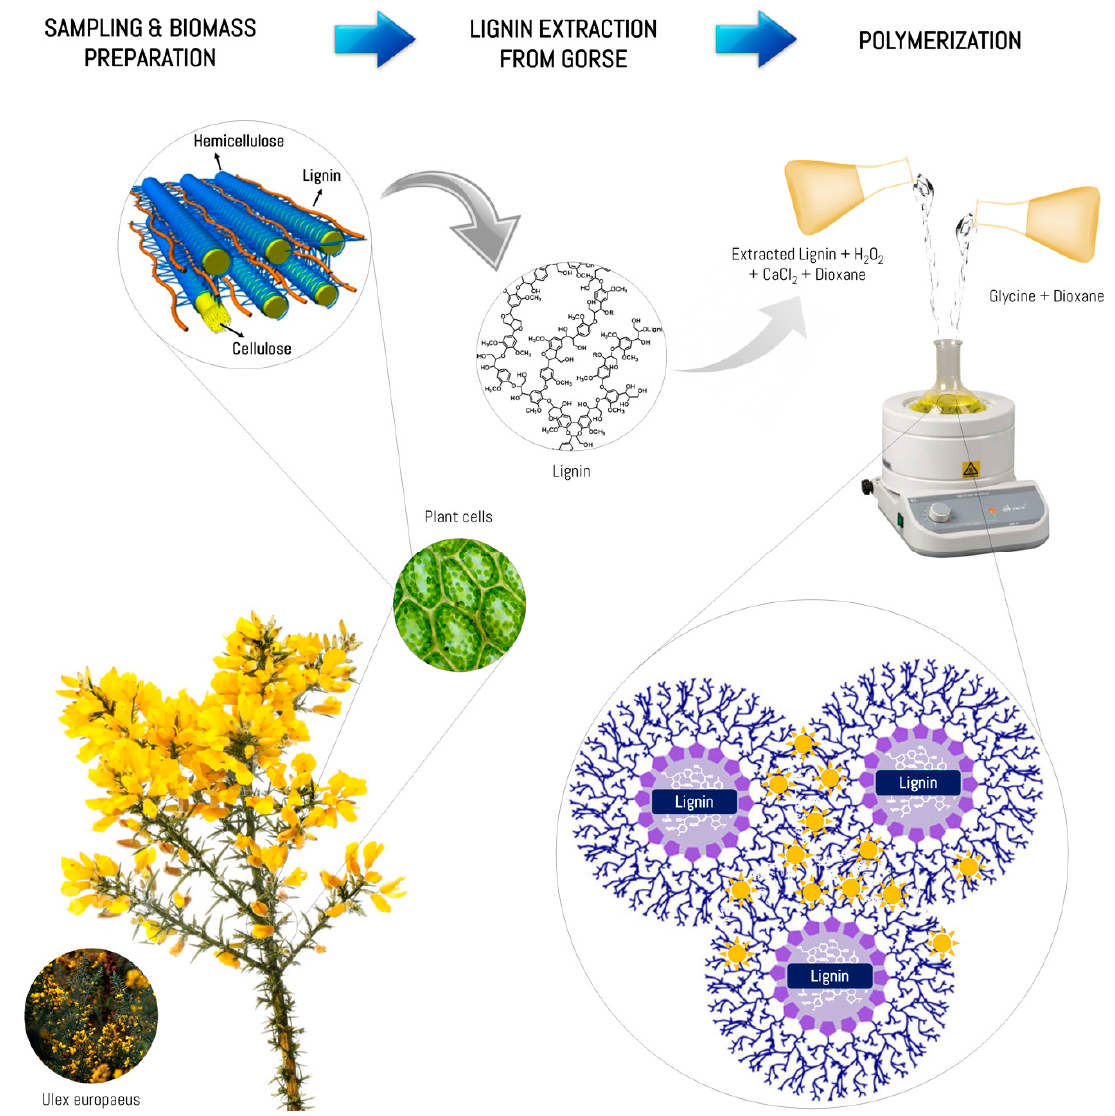
Figure 7. Production process and possible representation of the lignin-based biopolymer from Ulex europaeus . Although further research is needed to describe the relevant fragments of the polymer structure, it is possible that the obtained biopolymer contains a lignin nucleus with ramifications that are a product of the reaction with glycine. The purple pentagons represent the limits of the lignin core while dendrites the polymerization products. The yellow marks depict the hypothetical zones susceptible to crystallization in the cross-linked polymer.